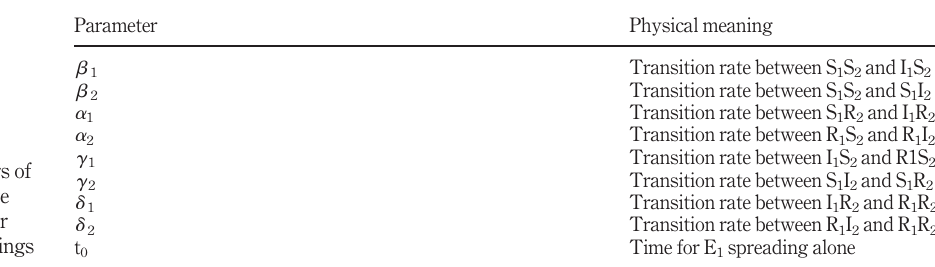
Table III. The parameters of the SIR mixture model and their physical